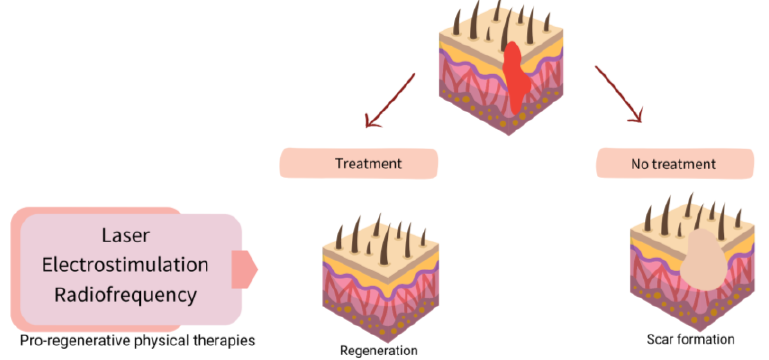
Figure 2. Diagram representing different targets with physical therapies (PT) for promoting wound healing (WH). PBM: photobiomodulation; LFU: low frequent ultrasound; PDT: photodynamic ther- apy; ES: electrostimulation; VPL: visible pulsed light; PEMF: pulsed electromagnetic fields; BT: biophotonic therapy; RF: radiofrequency.